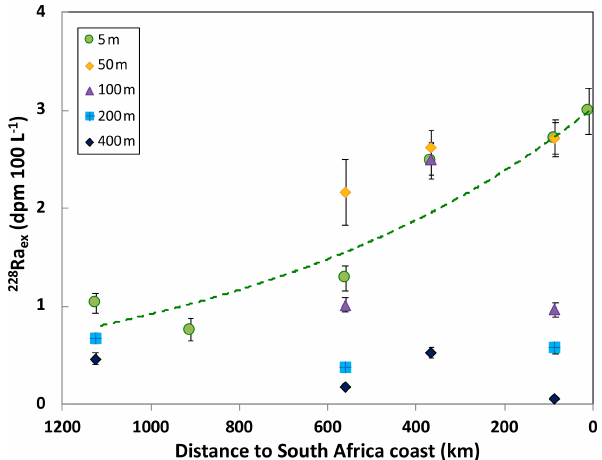
Figure 7. Plots of 228 Ra ex activity at water depths of 5, 50, 100, 200, and 400m versus distance to the coast of Cape Town in South Africa. The dashed line shows an exponential regression line through the data at